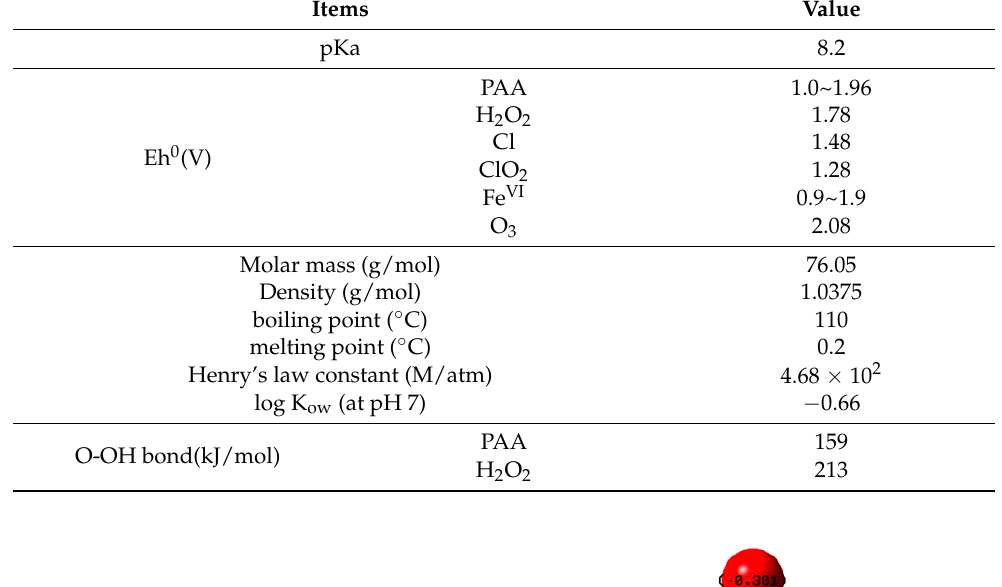
Table 1. Properties of PAA and other oxides.